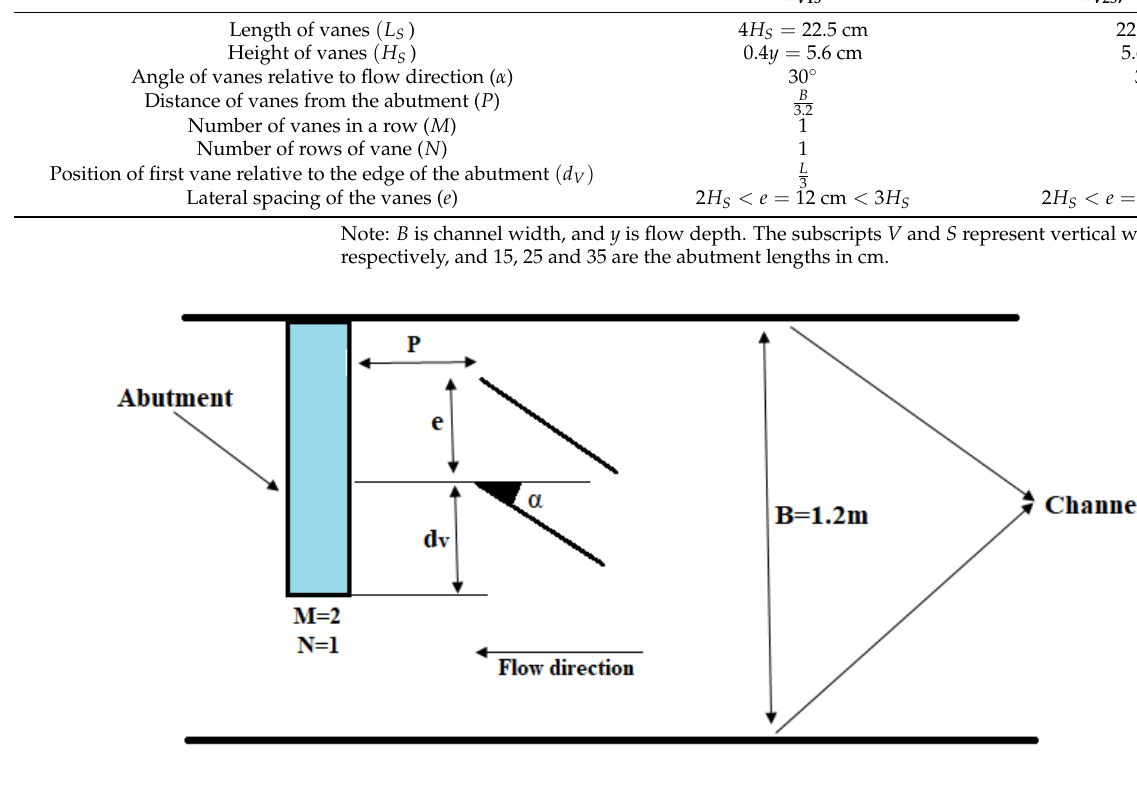
Figure 4. Plan view of channel and arrangement of vanes. Laboratory